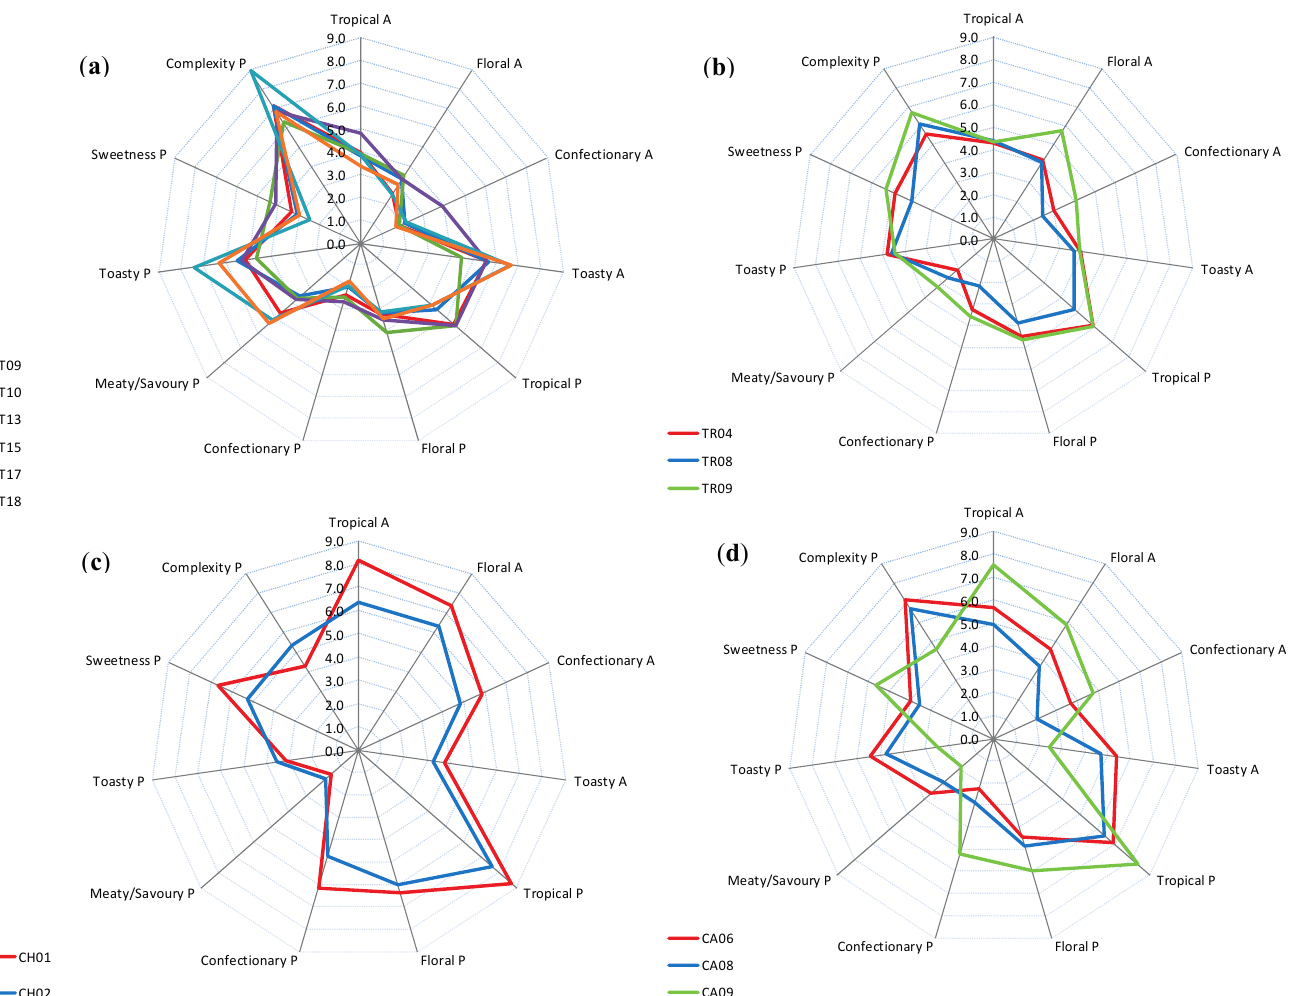
Figure 6. Sensory profiles of ( a ) Methodé Traditionelle ( n = 6); ( b ) Transfer ( n = 3); ( c ) Charmat ( n = 2); and ( d ) carbonated ( n = 3) sparkling wines that clustered in the circled regions A, B, C and D respectively, on the PCA score plot displayed as Figure 4a, (NB: circled regions comprise